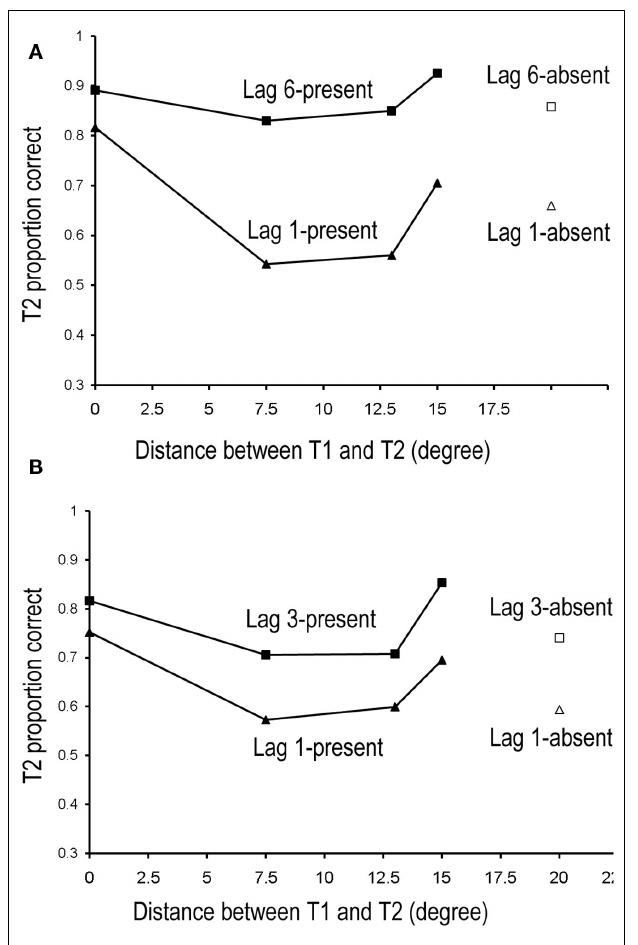
FIGURE 2 | Mean detection accuracy ofT2 when participants correctly reportedT1 for LL (A) and SL (B) groups in Experiment 1.